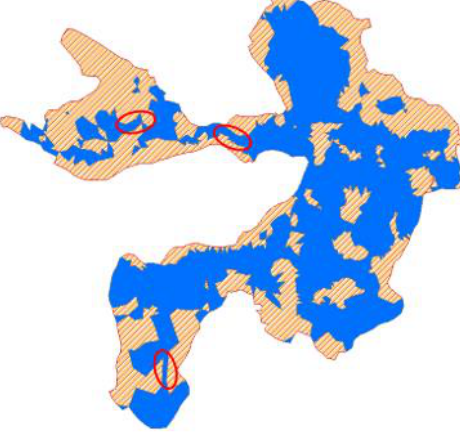
Figure 12. Modified landscape pattern for improving connectivity.